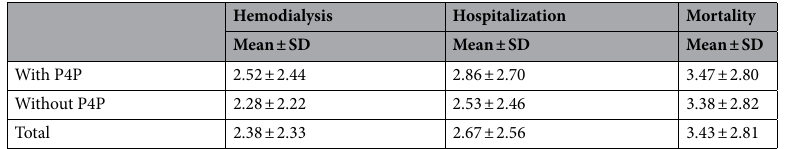
Table 3. Years to hemodialysis, hospitalization, and mortality in patients with CKD stages 3–5 with or without pay for performance program. P4P = pay for performance program; SD = standard